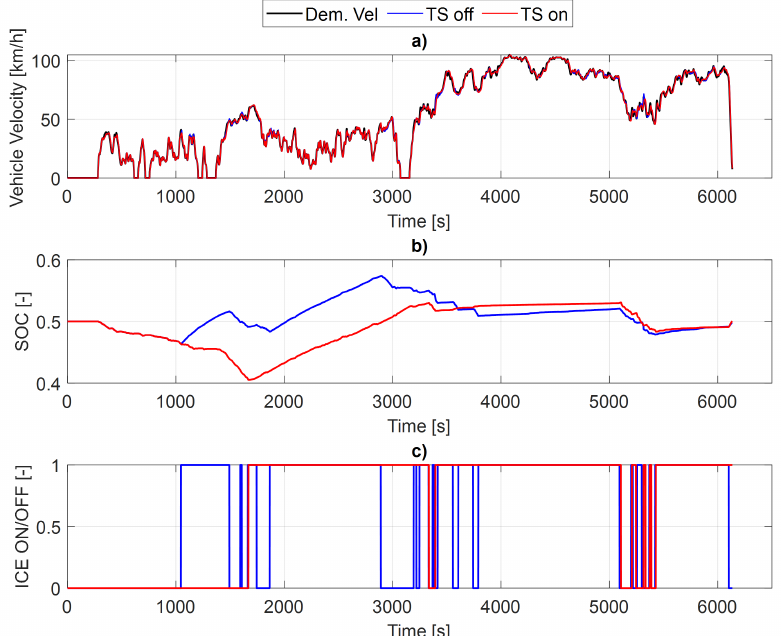
Figure 13. Simulation results for both control strategies during the RDE cycle. ( a ) Vehicle velocity. ( b ) State of charge of the battery (SOC). ( c ) ICE switch.